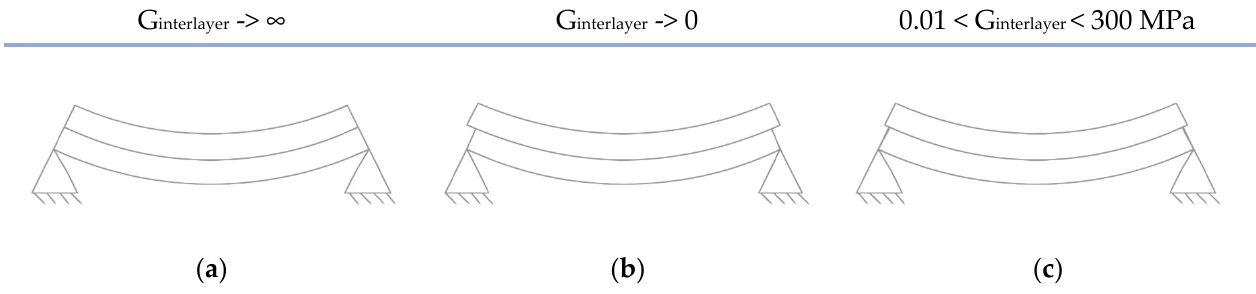
Figure 1. Laminated glass composed of two plies under bending: ( a ) monolithic limit; ( b ) layered limit; ( c ) intermediate configuration.